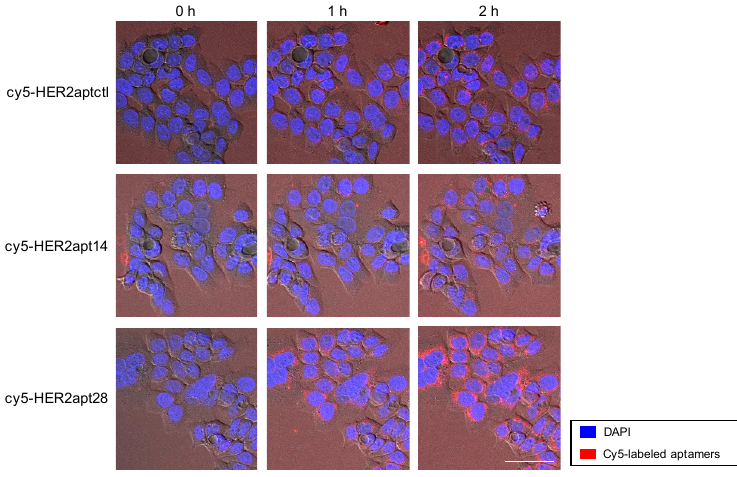
Figure 3. Confocal microscopic imaging of cy5-HER2apts internalization. NCI-N87 cells (3 × 10 5 ) were treated with Cy5-labeled aptamers (cy5-HER2aptctl, cy5-HER2apt14, and cy5-HER2apt28) and DAPI, and incubated at 37 °C for 2 h. The representative are merged images of DIC, DAPI, and Cy5. Internalization of aptamers was visualized using an LSM 780 confocal microscope. Representative fluorescent images were obtained at 0, 1, and 2 h post treatment with cy5-HER2apts. Original magnification, 40×; Scale bar, 20 μ m.